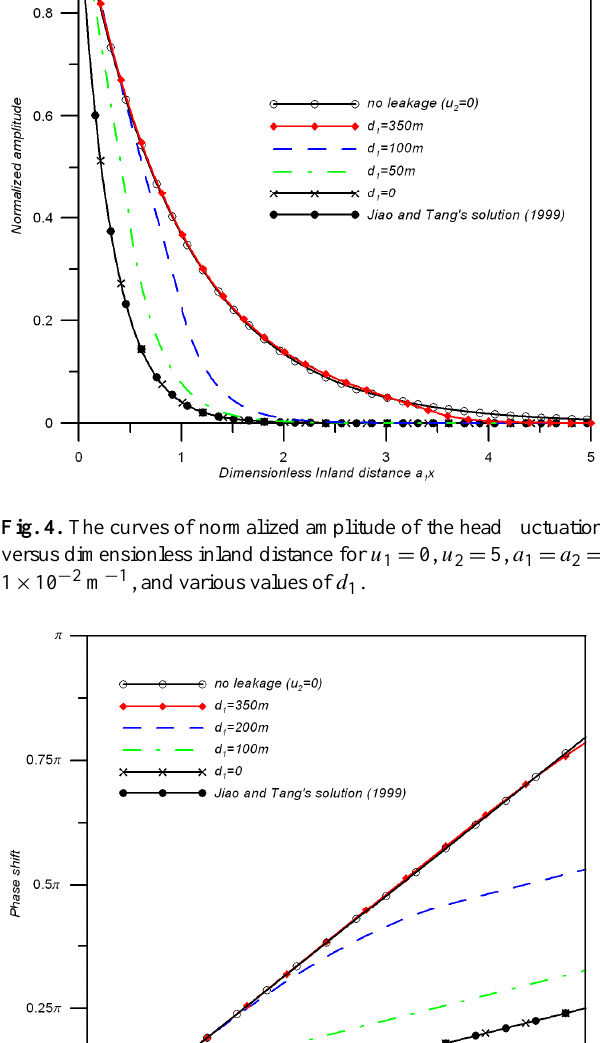
show that those dashed lines approach the line with large d 1 , indicating that the effects of the aquitard on the amplitude and phase shift decrease with increasing d 1 . Once the d 1 is larger than the tidal intrusion distance, the effects of the leak- age on both amplitude and phase shift become